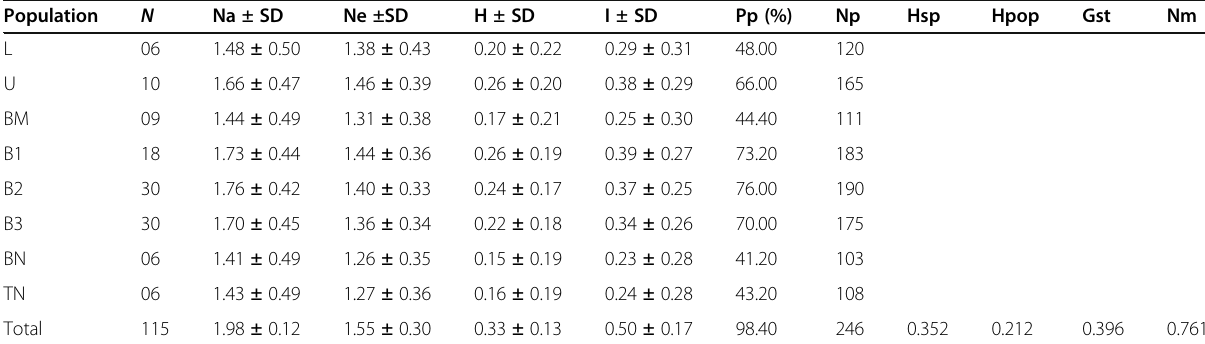
Table. 5 Genetic variations as revealed through combined SPAR approach among eight populations of I . griffithii Population